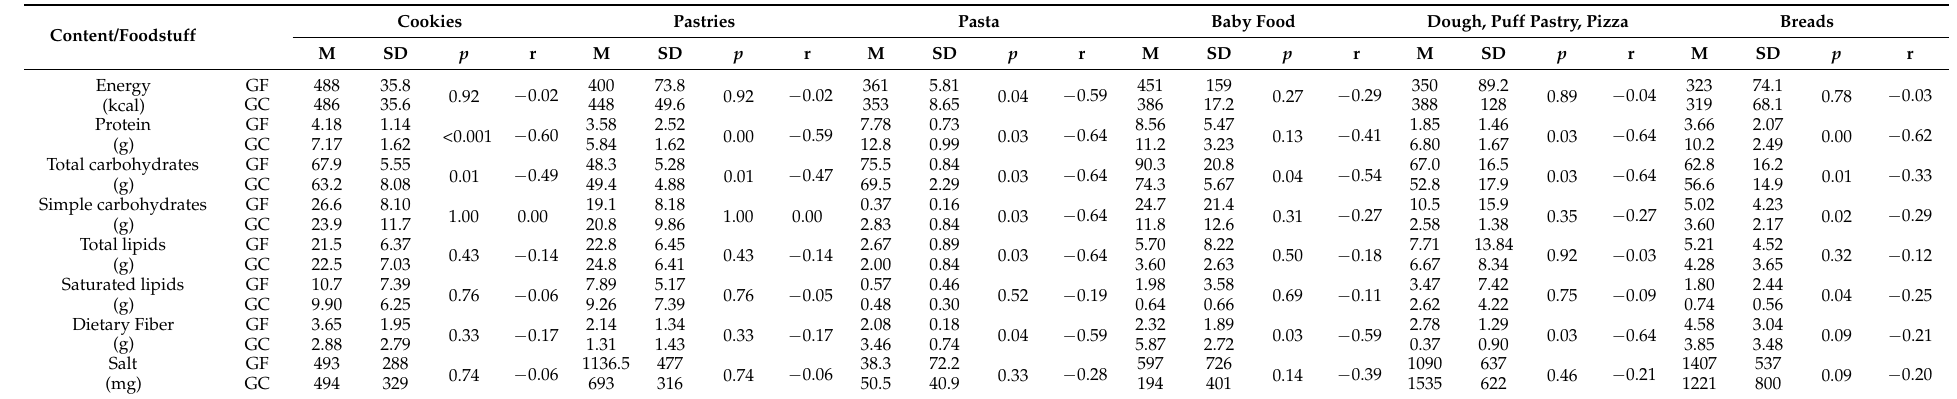
Table 2. Energy, protein, total carbohydrates, simple carbohydrates, total lipids, and saturated lipids content per 100 g of products in gluten-containing and gluten-free rendered foodstuffs classified by food